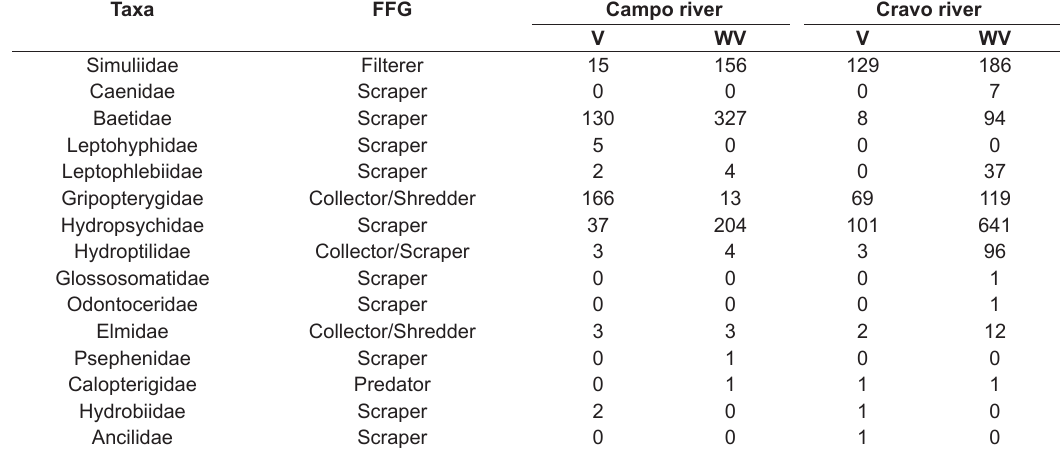
Table 3. Invertebrates abundance and functional feeding group (FFG) associated in Campomanesia xanthocarpa in the Campo river hydrographic basin and Cravo river hydrographic basin, Southern Brazil.